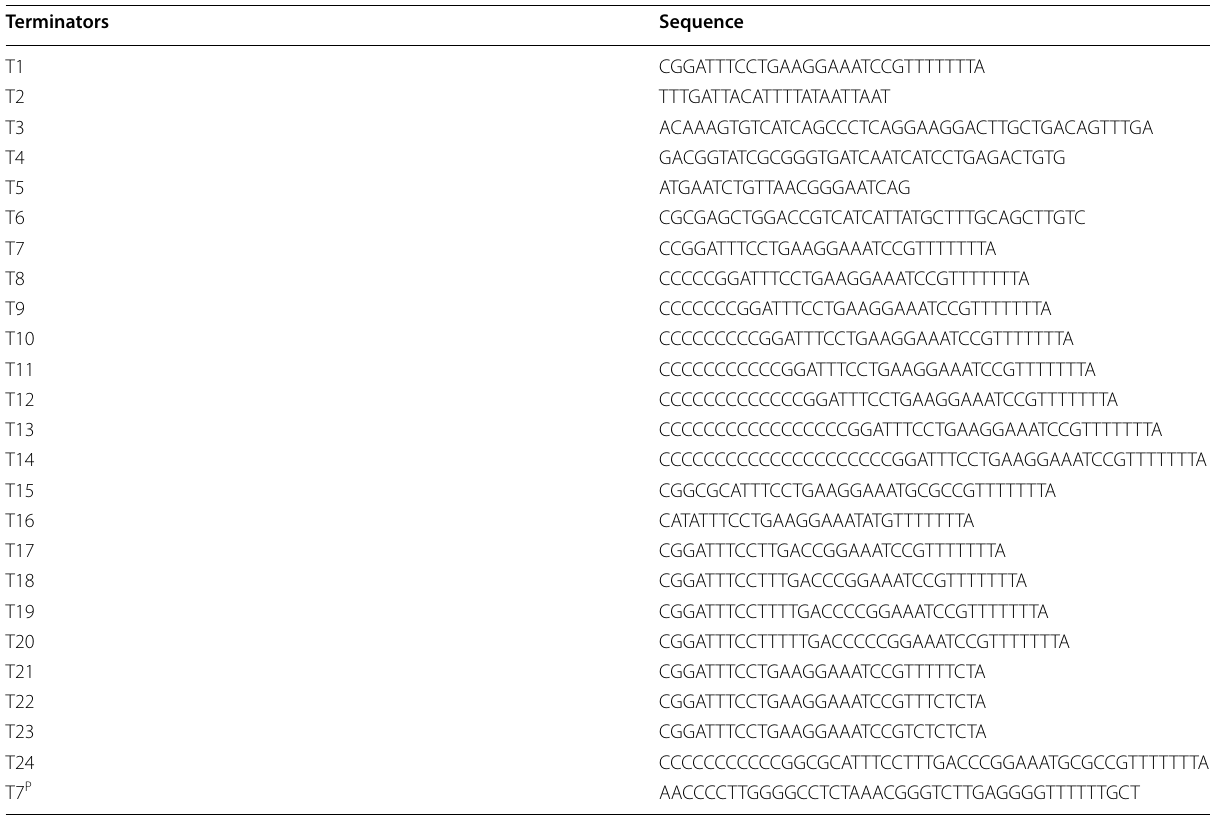
Table 1 The design sequences of different terminators Terminators